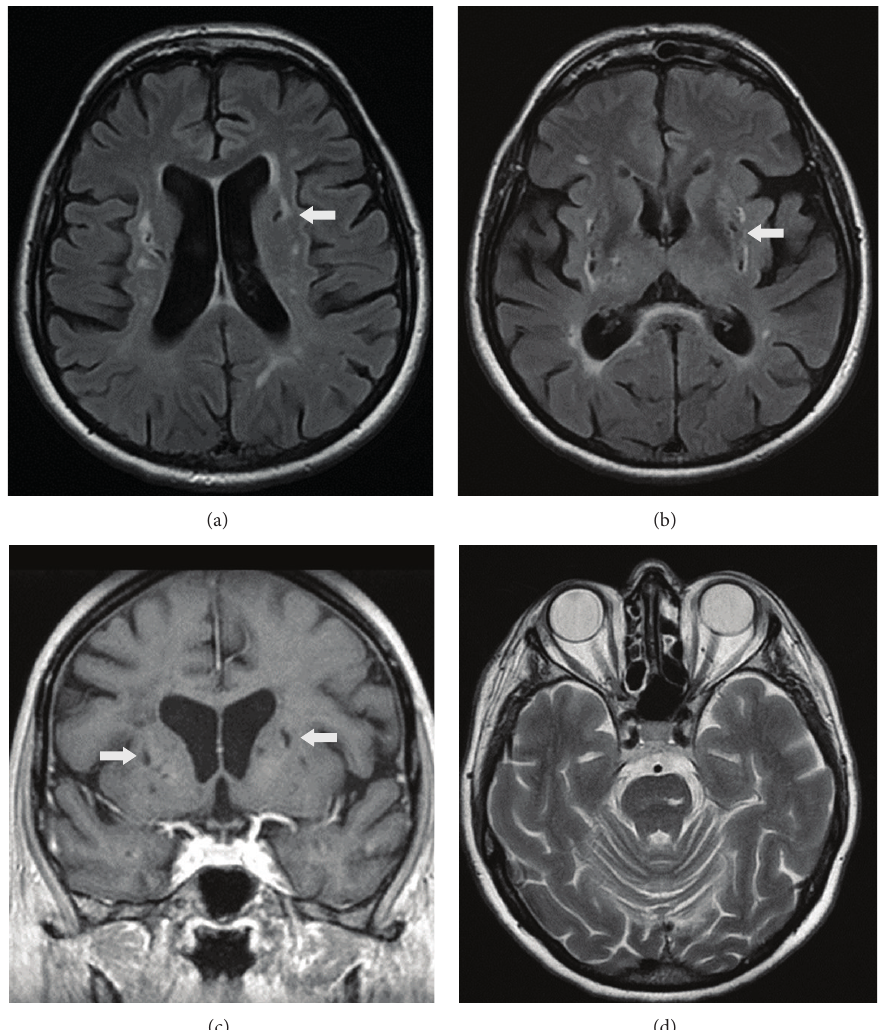
Figure 1: Cerebral MRI: lacunar state, with prominent lesions on the left caudate ((a and c) arrow), bilateral putamen ((b and c) arrow), and left pons